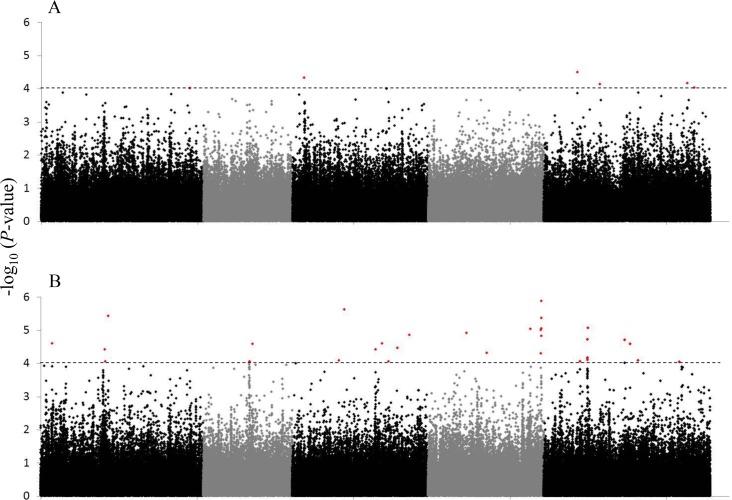
Manhattan plots for GWA of variation in Aleyrodes proletella performance.Associations between SNPs and adult survival (A) or oviposition rate (B) are shown. Each SNP is represented by a single dot with the candidate SNPs (-log10(P) > 4, MAF > 5%; horizontal dashed line) plotted in red. SNPs with a MAF < 5% were not included in the analysis. Arabidopsis thaliana chromosomes 1–5 are shown in contrasting colors from left to right on the x-axis.